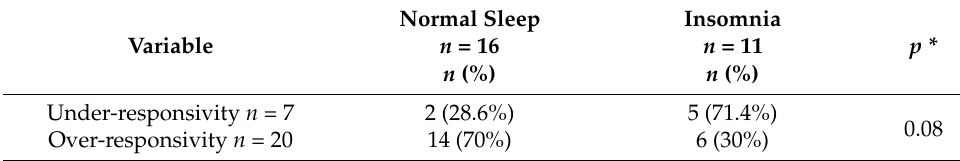
Table 3. An association of TSM and sleep difficulties.